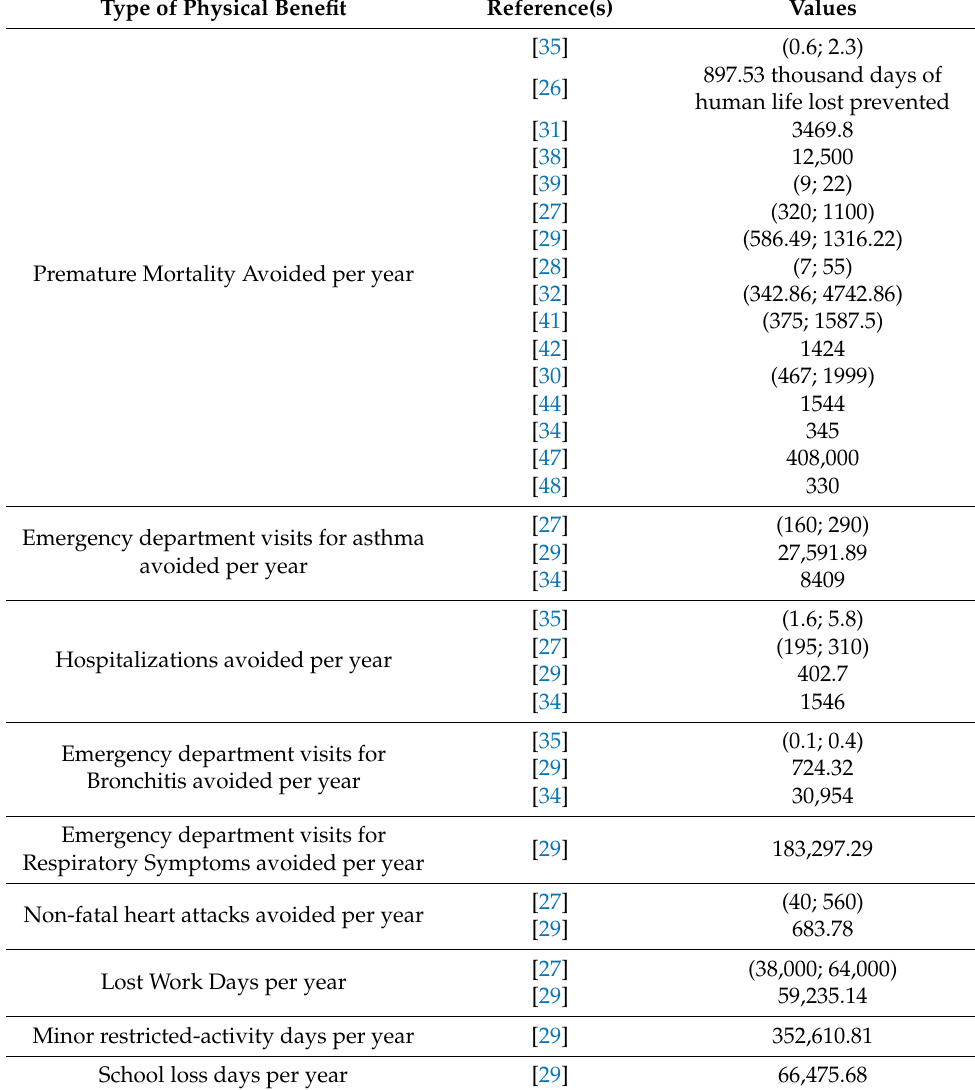
Table 8. Absolute physical benefits (source: own elaboration).